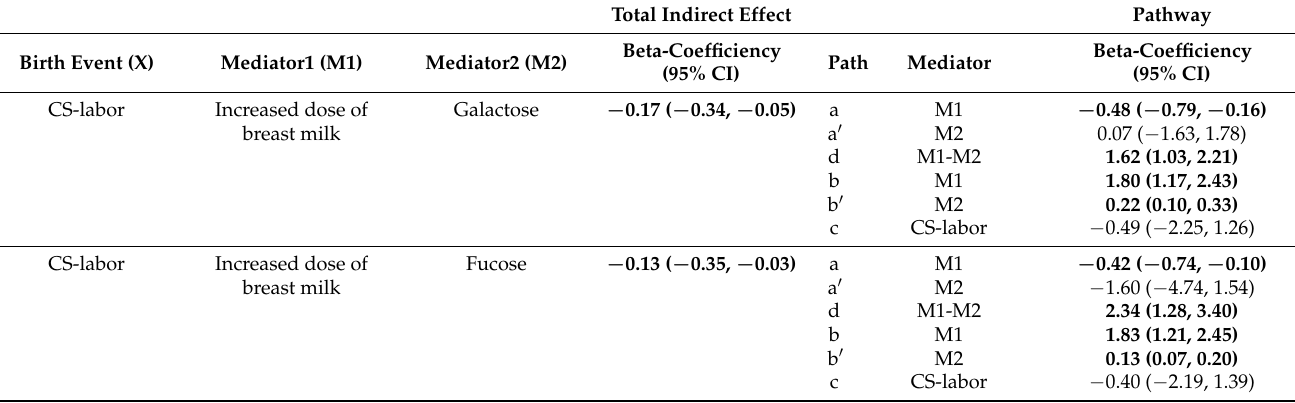
Table 1. The indirect effect of birth events on fecal SIgA level at 3 months through microbe-metabolite pathways, adjusted for gravida status †